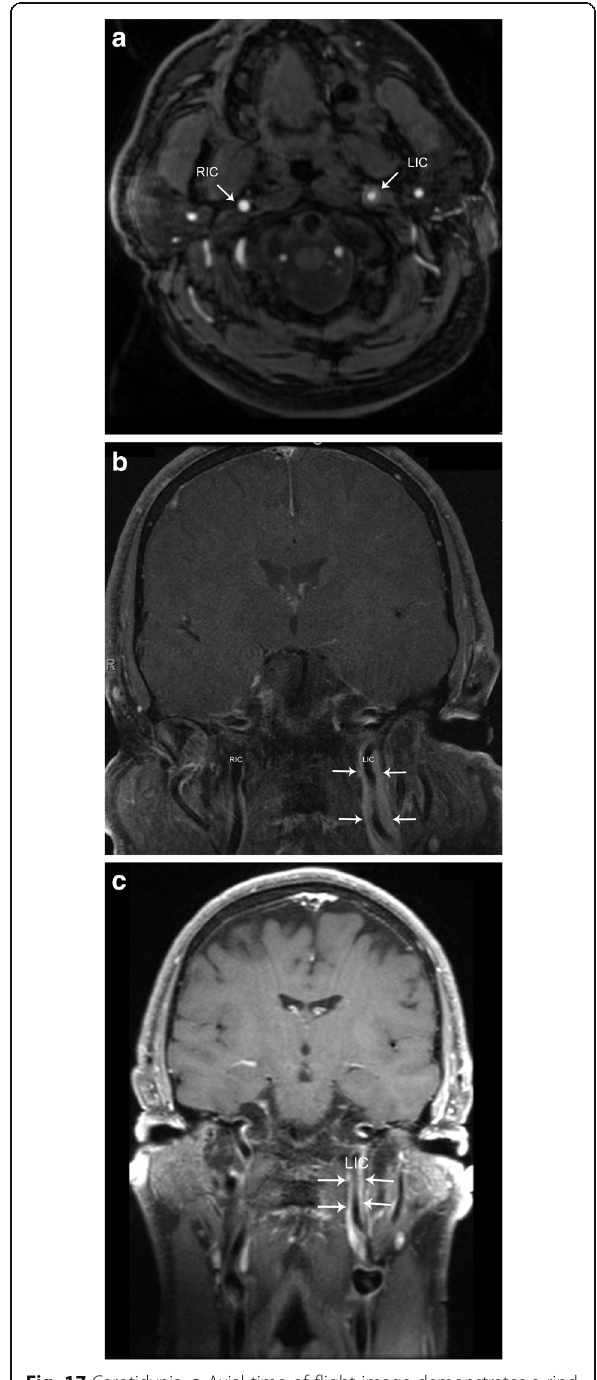
Fig. 17 Carotidynia. a Axial time of flight image demonstrates a rind of soft tissue surrounding the left internal carotid artery (LIC). Note the normal appearance of the right internal carotid artery (RIC). b Coronal post-contrast T1-weighted image shows avid enhancement of the rind of soft tissue (arrows) surrounding the left internal carotid artery (LIC). Note the normal appearance of the right internal carotid artery (RIC). c Follow-up approximately 4 months later, coronal post-contrast T1-weighted fat-saturated image shows decreased thickness of the rind of soft tissue